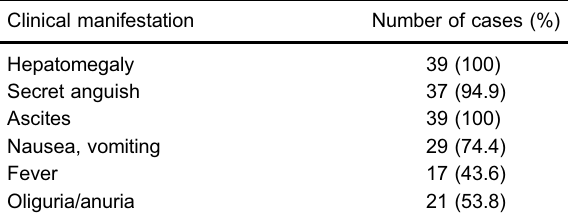
Clinical manifestation